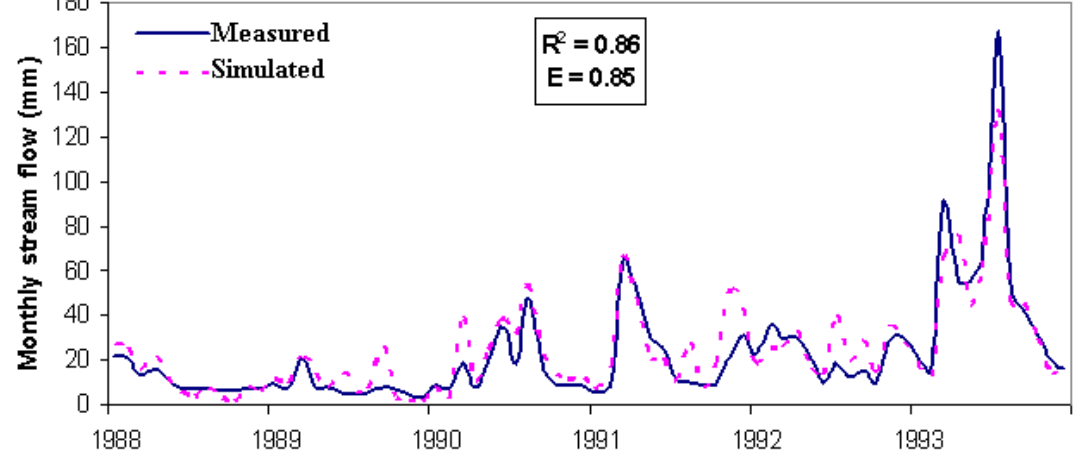
Figure 4. Monthly time series of predicted and measured streamflow at USGS gauge 05418500 (watershed outlet) for the 1982-87 validation